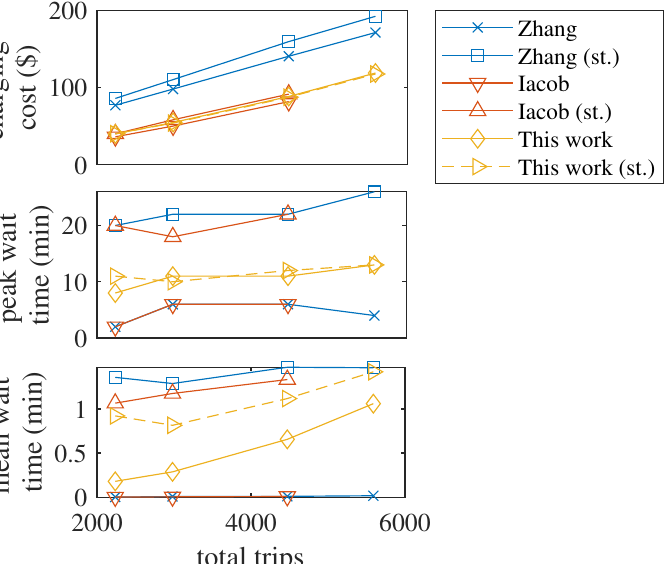
Figure 8. Total charging costs and mean waiting times for the benchmark models and the proposed model. Results are for the scaled-down scenario with 10 nodes over 5 days.